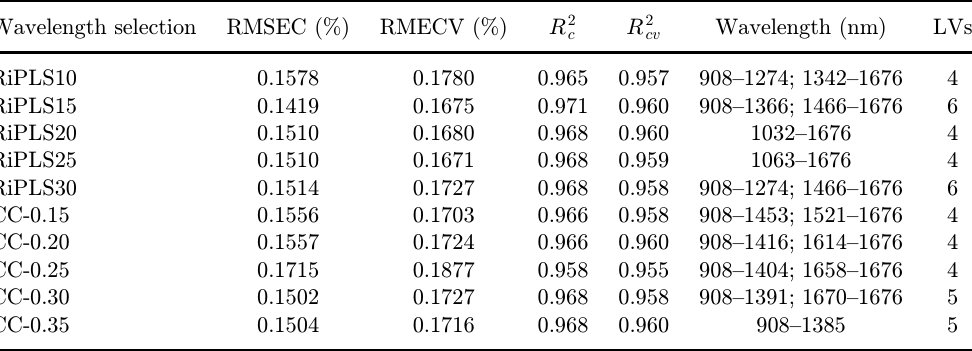
Table 2. The results of PLS models with di®erent wavelength selection methods. Wavelength